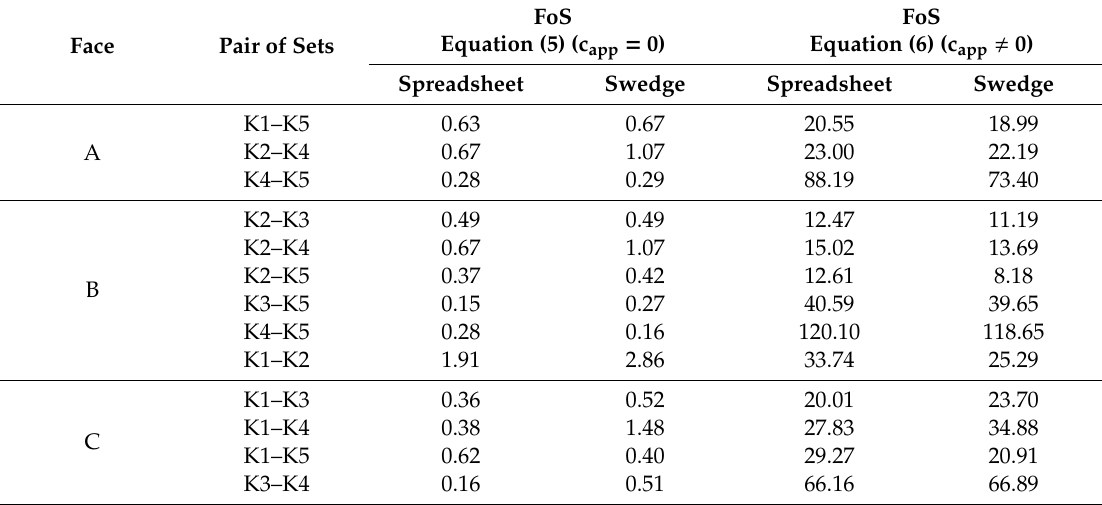
Table 8. Summary of results in terms of FoS with respect to wedge sliding mechanism for excavation faces A, B, and